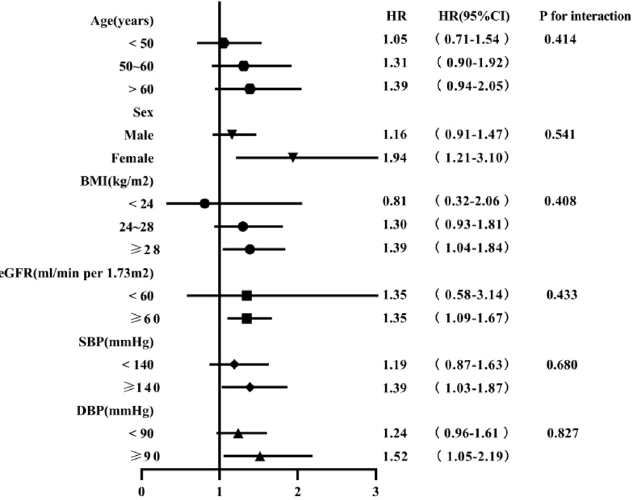
Figure 3. Stratified analyses of the association between the TyG index and the incidence of hyperuricemia. Adjusted for age, sex,HDL-C, LDL-C, BMI, eGFR, 24hTP, SBP, DBP and